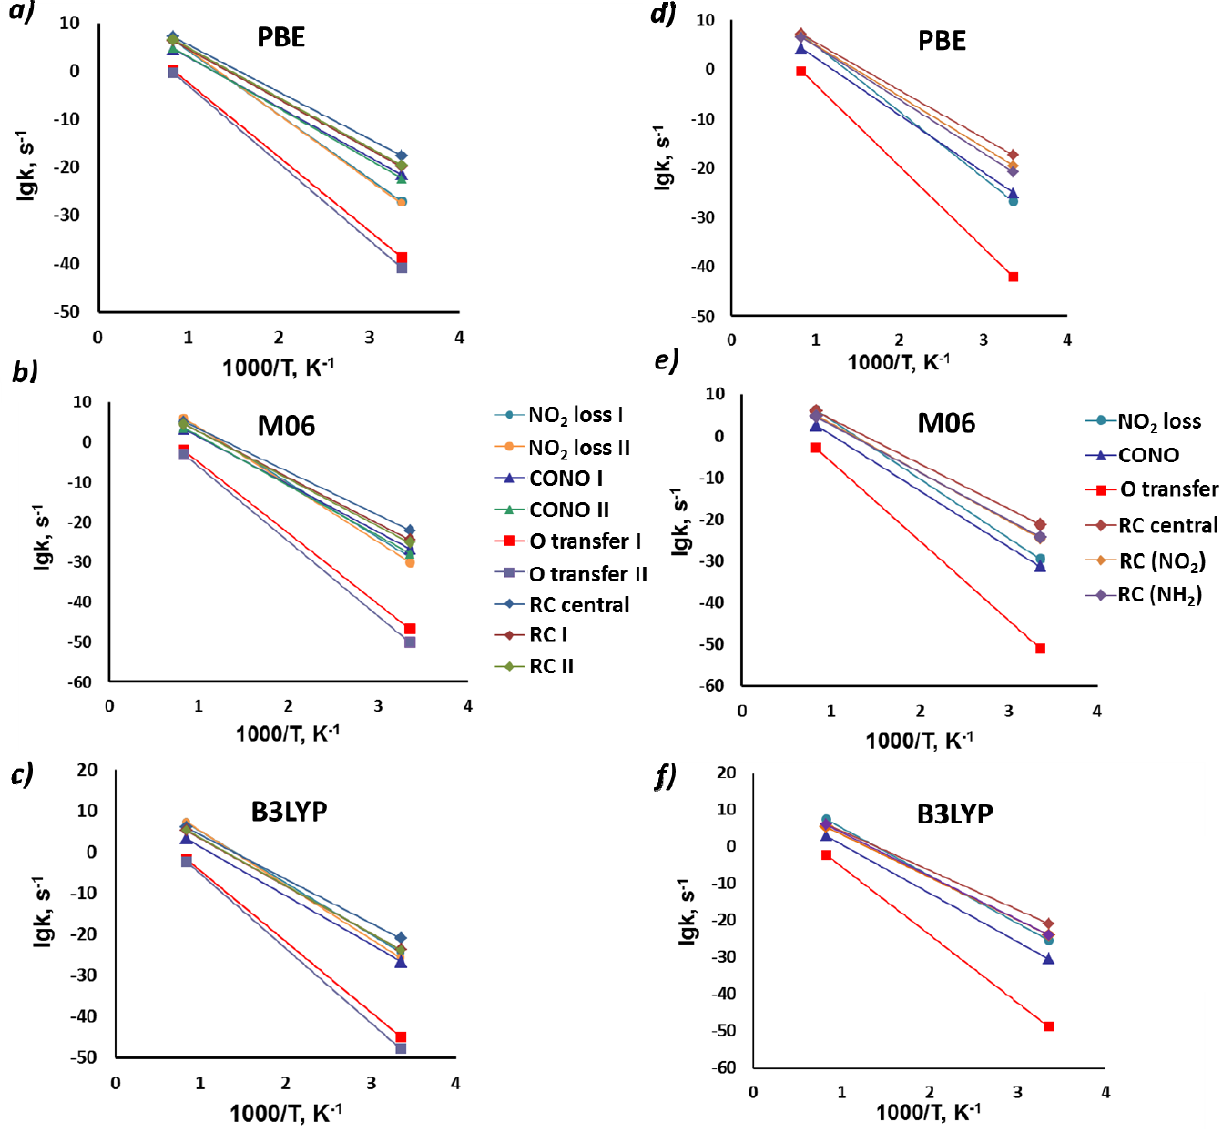
Figure 6. Reaction rates of the simulated decomposition channels of BNFF-1 ( a – c ) and ANFF-1 ( d – f )